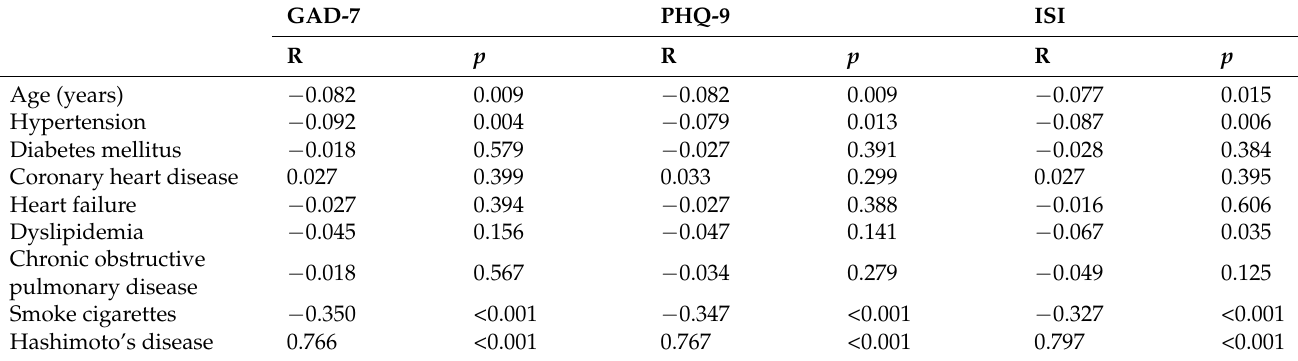
Table 2. Analysis of correlations between selected parameters and GAD-7, PHQ-9, and ISI scores.